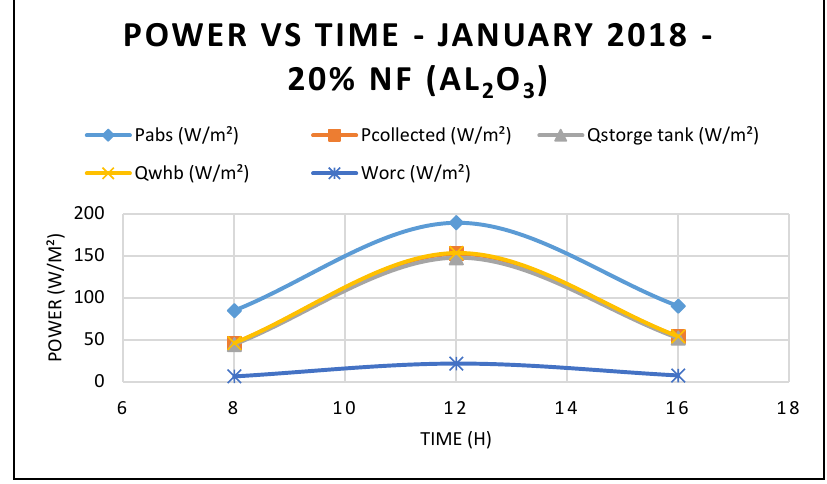
Figure 8. Characteristics of the CSP collector and hybrid system at concentration of 20% of Al 2 O 3.